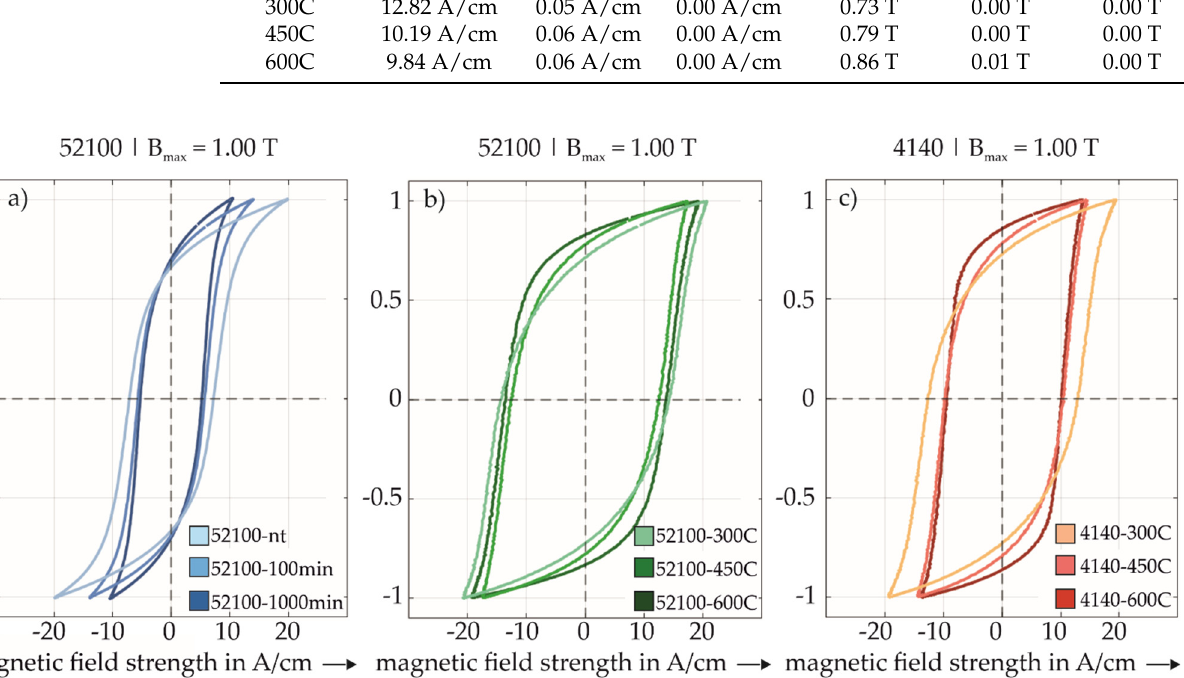
Figure 4. Magnetic hysteresis of the investigated specimens in different tempering states using the measurement setup shown in Figure 2a. For each hysteresis, B max was set to 1 T, using various excitation amplitudes: ( a ) 52100-nt (2.1 V), 52100-100 min (1.6 V), 52100-1000 min (2.1 V), ( b ) 52100- 300C (0.7 V), 52100-450C (0.6 V), 52100-600C (0.7 V), ( c ) 4140-300C (0.6 V), 4140-450C (0.6 V),